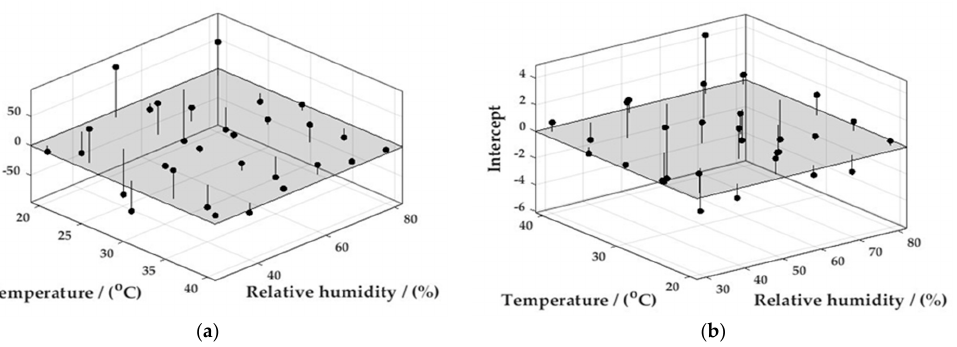
Figure 9. MATLAB residuals plots resulting from the calibration curves measured across an environmental envelope for, ( a ) Gradient and ( b ) Intercept.